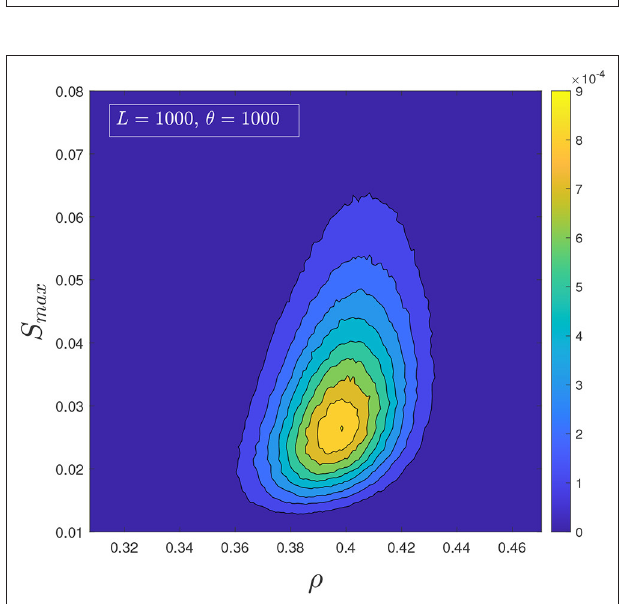
FIGURE 8 | Heatmap representing the bivariate histogram of the normalized largest cluster and the density.